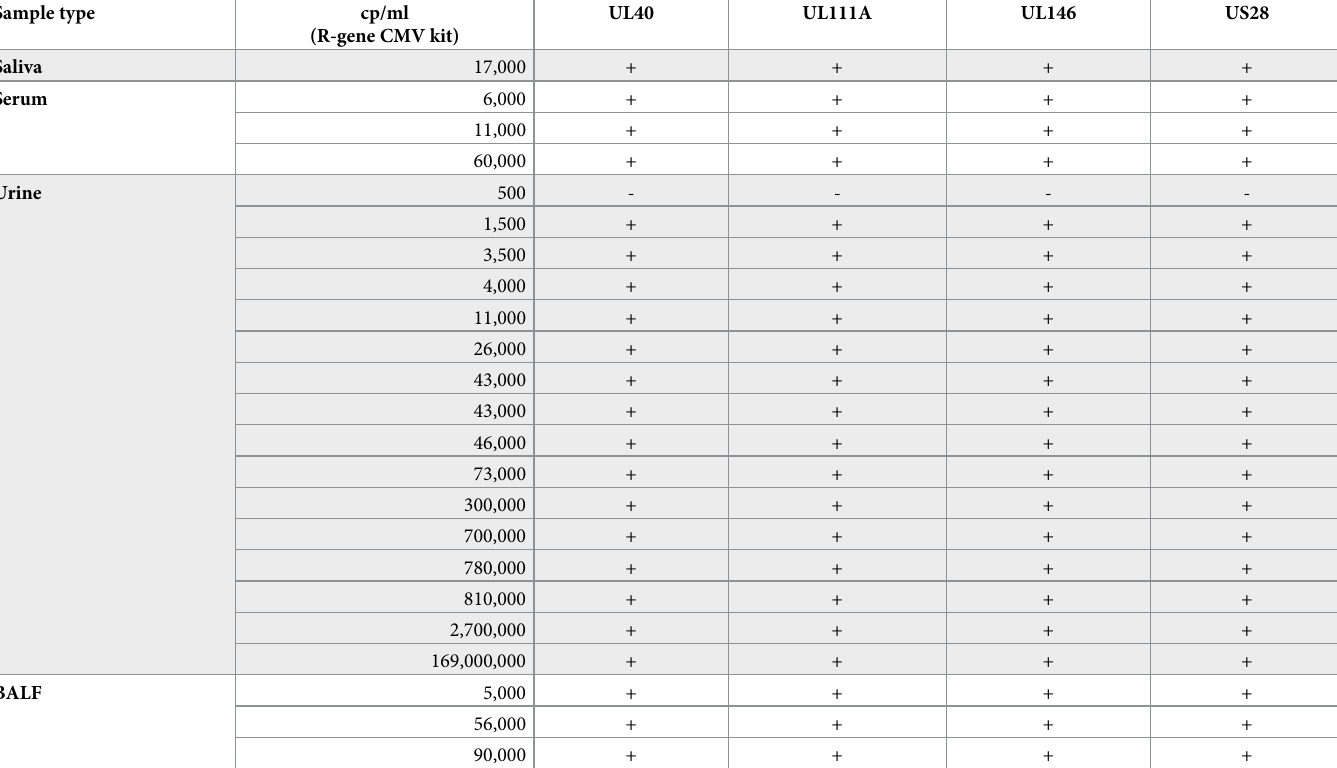
Table 2. Test of specific PCRs for detection of CMV target genes (UL40, UL111A, UL146, and US28) from different virus isolates in different clinical sample types (saliva, serum, urine, and bronchoalveolar lavage fluid/BALF). Sample type